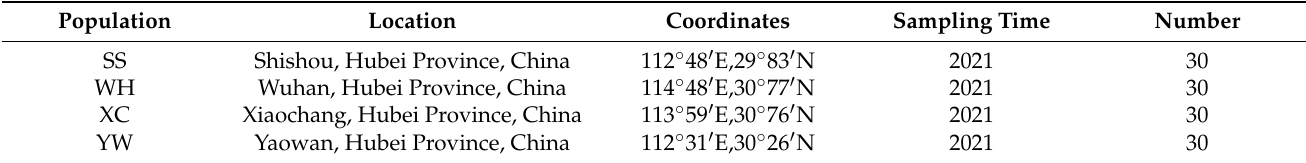
Table 1. Sample information of the cultured H. molitrix populations in this